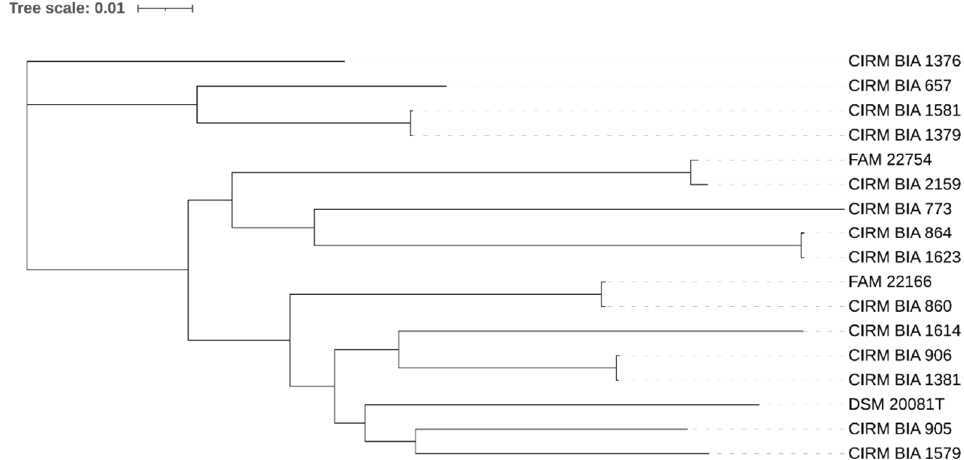
Figure 1. SNP-based phylogenetic tree of Lactobacillus delbrueckii subsp. bulgaricus strains assessed in this study. The scale shows the rate of single nucleotide polymorphisms.